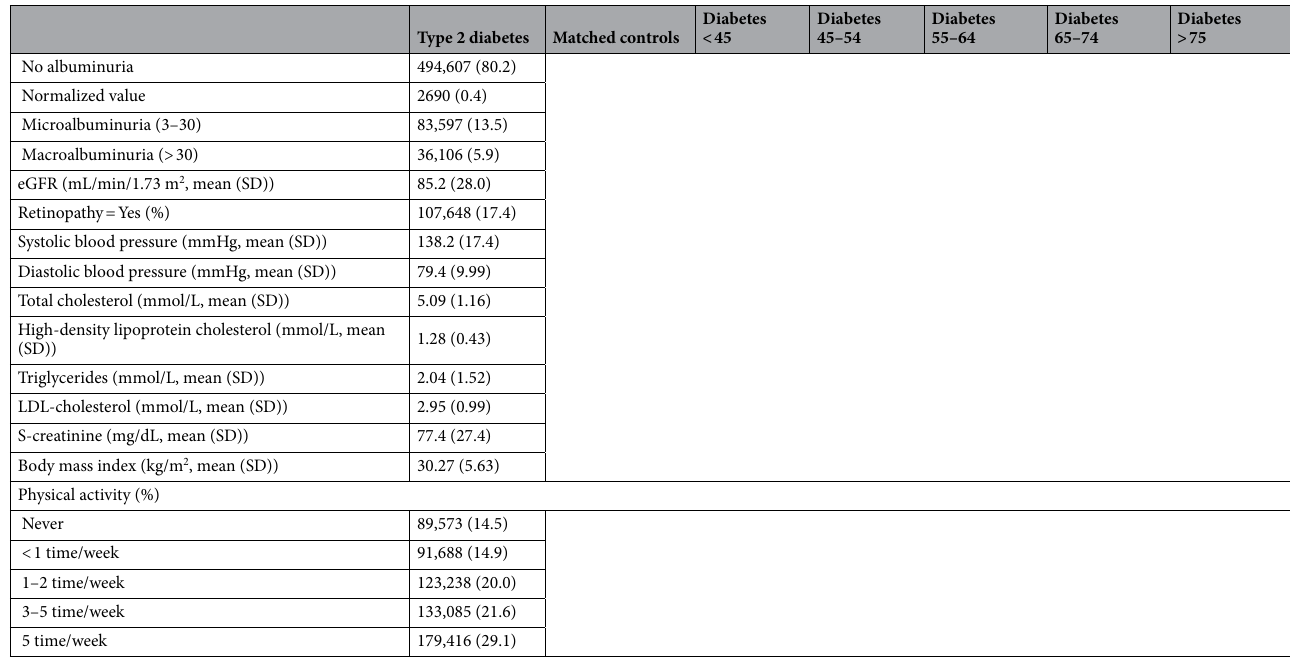
Table 1. Baseline characteristics for patients with type 2 diabetes, along with matched controls from the general population. Values are mean (SD). Income and eGFR is reported as median (inter quartile range [IQR]). Glomerular filtration rate was estimated using the Modification of Diet in Renal Disease Study Equation. Controls are individuals, matched for age, sex and county, who were randomly selected from the general population. *Concentrations of glycated haemoglobin are based on values from the International Federation of Clinical